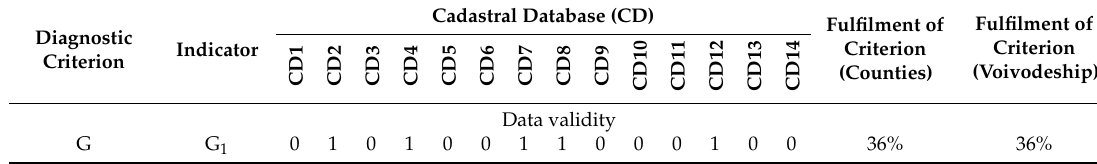
Table 15. Evaluation of Cadastral Databases Based on Criterion